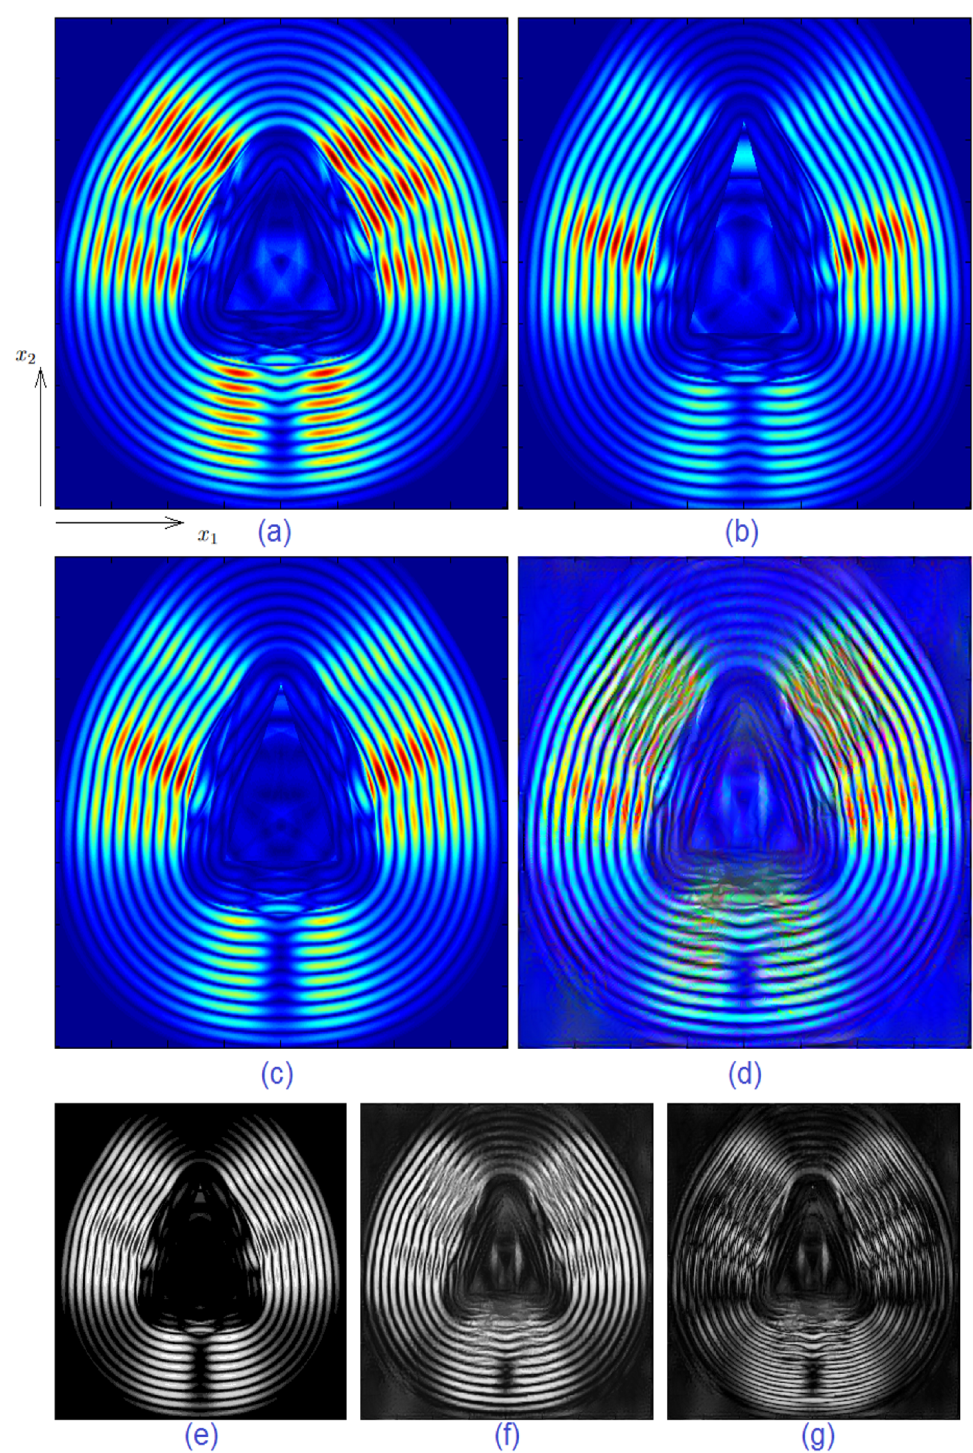
Fig. 5. Snapshot time t = 710 m s for the radiation pattern of a point force (directed along x 2 ) vibrating at frequency 10kHz and located at the gravity point of an isosceles triangle of height 4 20 cm (b), isosceles triangle of height 5 Note the weak similarities between (c) and (d). (e) is (c) transformed in a grayscale image, (f) is (d) transformed in a grayscale image and (g) is the absolute value of the difference between (e) and (f). Note that the size of the fi eld is 80 cm by 80